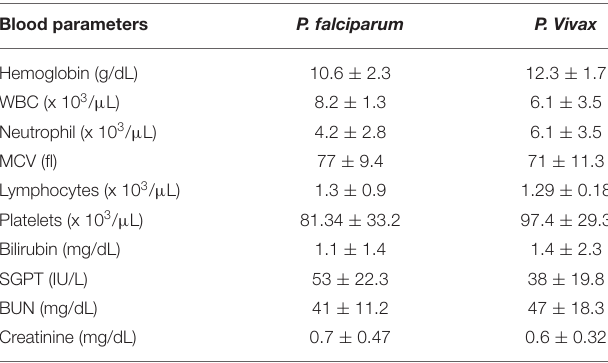
TABLE 4 | Blood parameters in Plasmodium Vivax and Plasmodium Falciparum . Blood parameters